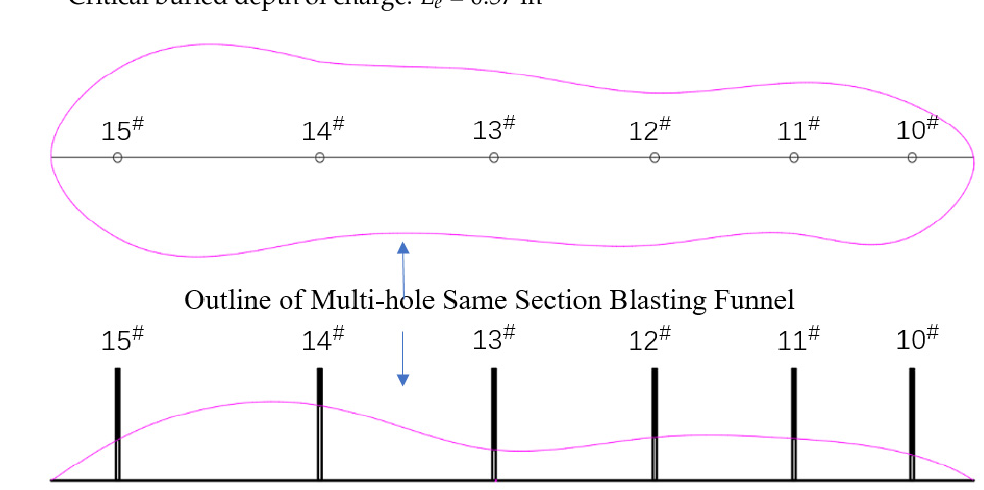
Equations (7) and (8) gives: